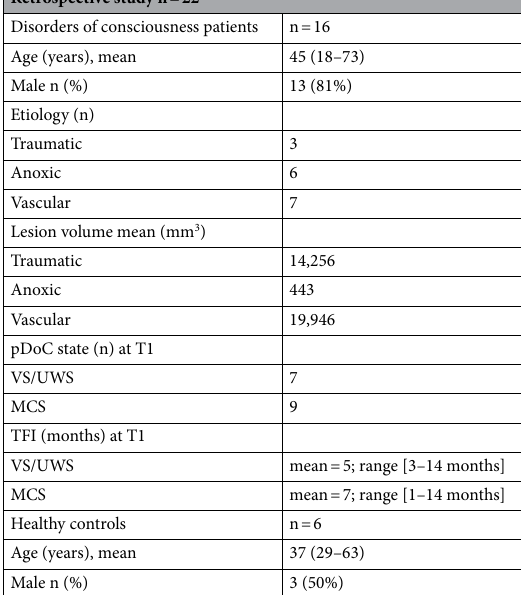
Table 1. Patient characteristics. Report of the demographic and etiology characteristics of the cohort analyzed (n = 22); TFI = Time from